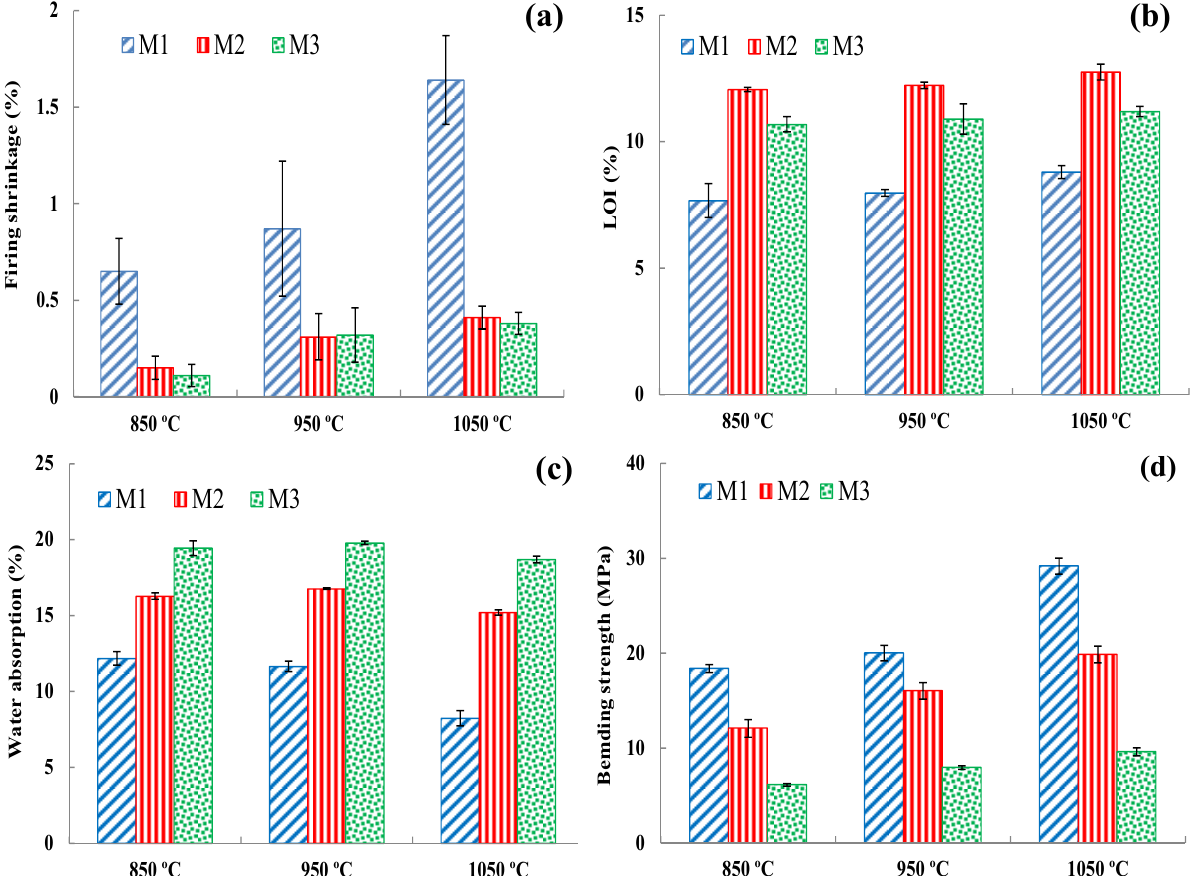
Figure 17. Outcomes of physical and mechanical features of fired mixtures (M1, M2, and M3): ( a ) firing shrinkage (%), ( b ) LOI%, ( c ) water absorption (%), and ( d ) bending strength (MPa).